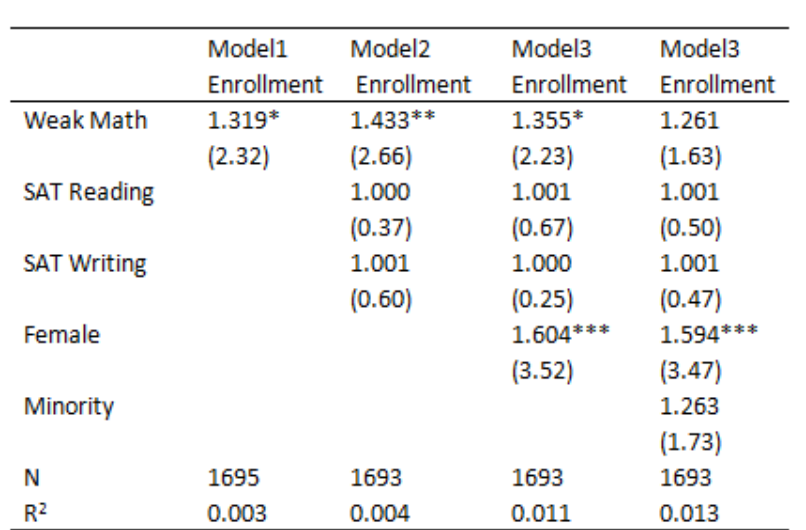
Odds Ratios From Logistic Regression Models Predicting MOOC